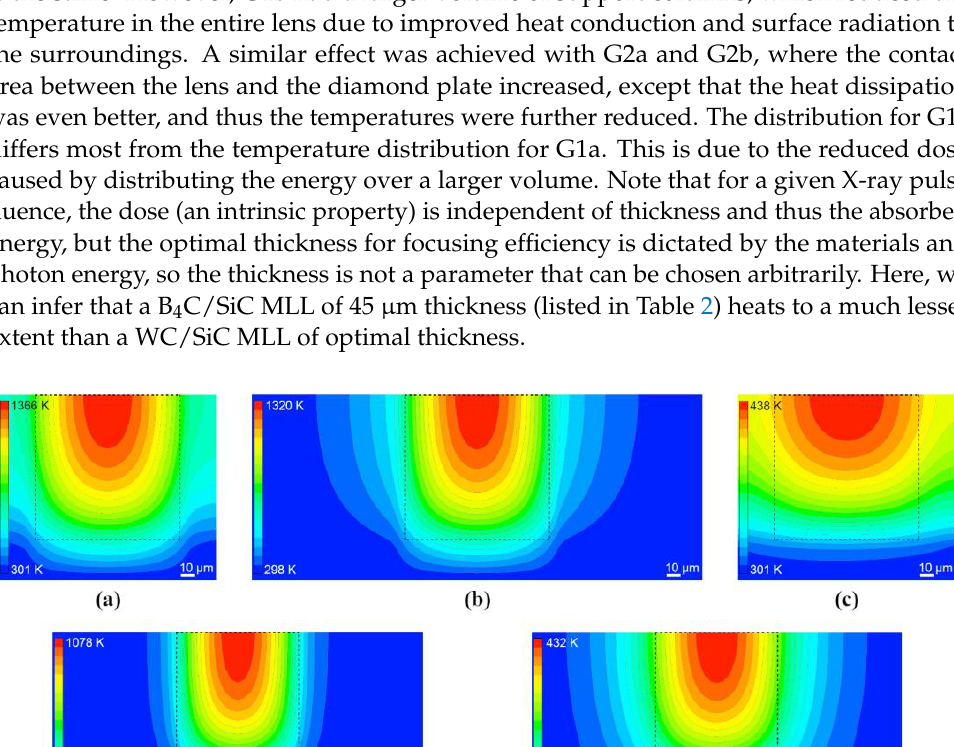
11 of 18 Figure 6. Maximum MLL (WC/SiC) temperature for three mesh densities. 4. Simulation Results and Discussion 4.1. Comparison of Geometries and Materials for a Constant Absorbed Energy Per Pulse In the following, we present the results of the numerical study of the heating of MLLs using the model described above and with an absorbed energy per pulse of abs Q = 15.6 µJ, similar to the experimental conditions, as well as for higher absorbed energies. In par- ticular, we studied the responses of different lens geometries, mounting, and materials, under various XFEL beam conditions (intensity, number of pulses, etc.). The numerical simulations predict that each XFEL beam pulse causes a huge instan- taneous and volumetrically uniform heat load on the MLL (Equation (5) and Table 3).